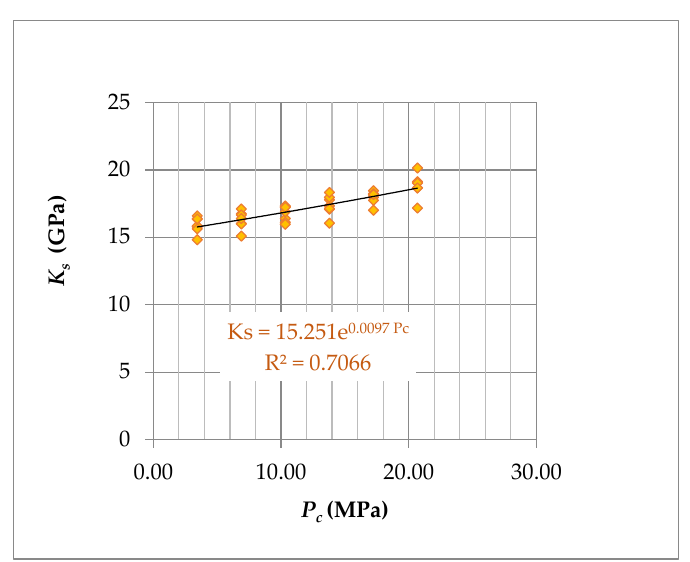
Figure 6. Calculated values of 𝐾 𝑠 as a function of the hydrostatic stress (Method 2).